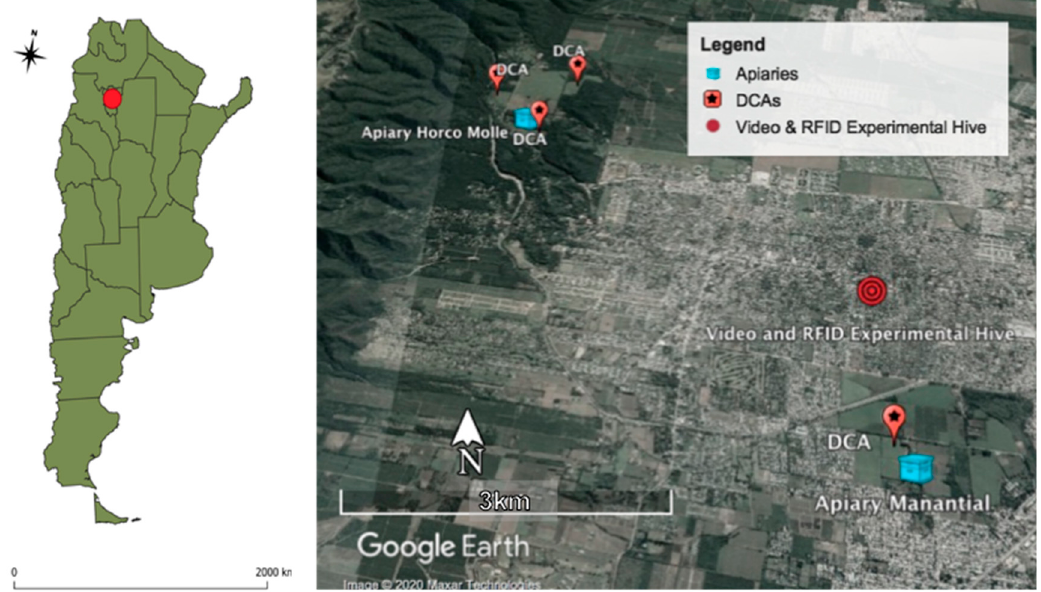
Figure 1. Map of Argentina and Radio-Frequency Identification (RFID) experimental hive in an urban landscape, with two apiaries and four drone congregation areas (DCAs) (Google Earth ® ).